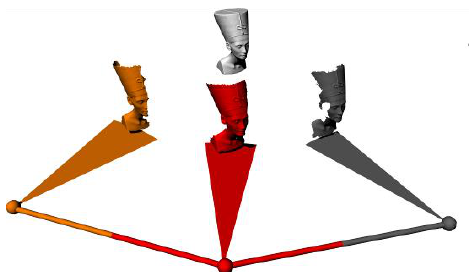
Figure 11. Acquired data from viewpoints 1 (grey), 2 (red) and 3 (orange) with object of interest in the background